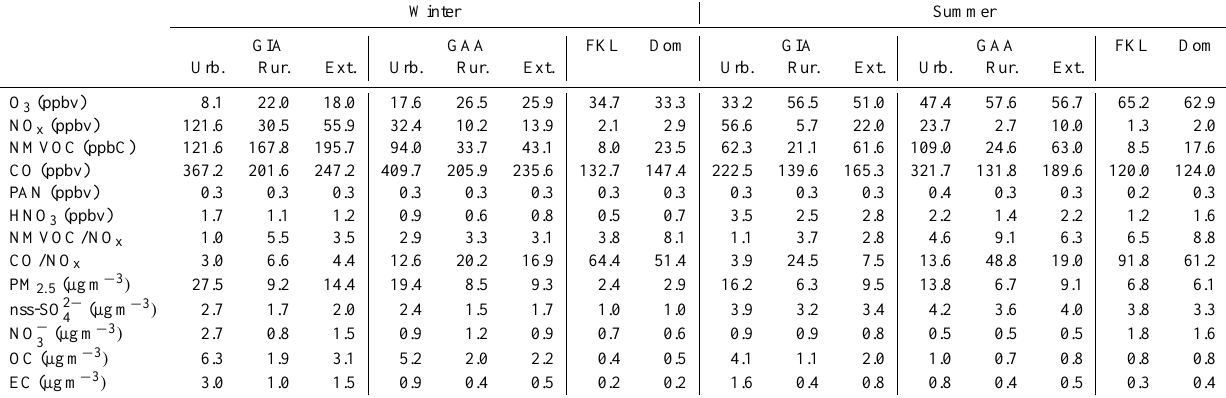
Table 4. Surface concentrations of main gaseous and particulate pollutants and NMVOC/NO x and CO/NO x molar ratios simulated for the base case over urban (Urb.), rural (Rur.) and the extended areas (Ext.) of GIA and GAA, at Finokalia (FKL) and the whole simulation domain (Dom), averaged over the 31-day periods in winter (December 2008) and summer (July